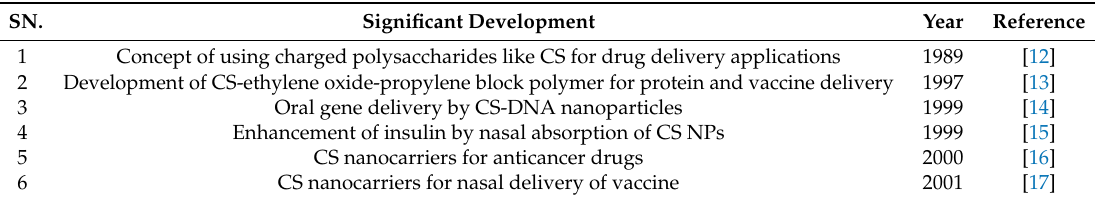
Table 2. Evolution of CS based materials in bionano